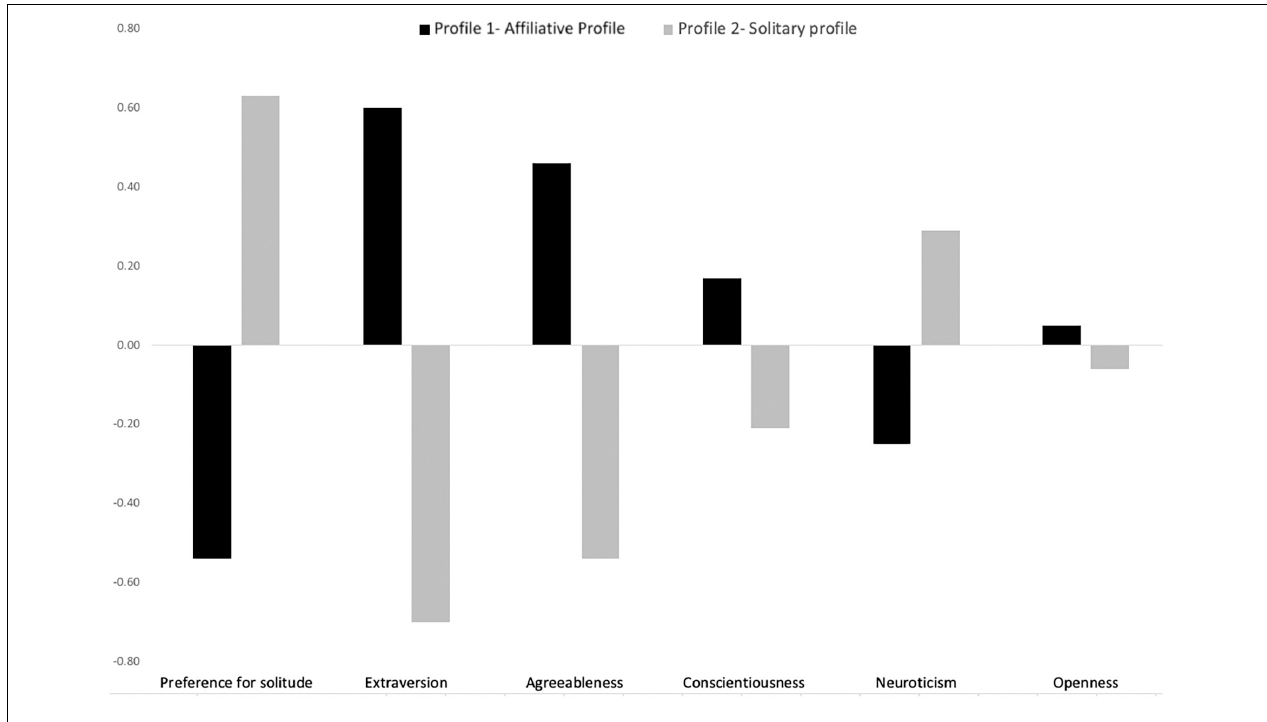
FIGURE 4 | Two profiles based on personality variables. TABLE 5 | Mean differences and standard deviations (SD) in study variables among the two profiles. “Affiliative” profile Mean (SD) “Solitary” profile Mean (SD) t p Cohen’s